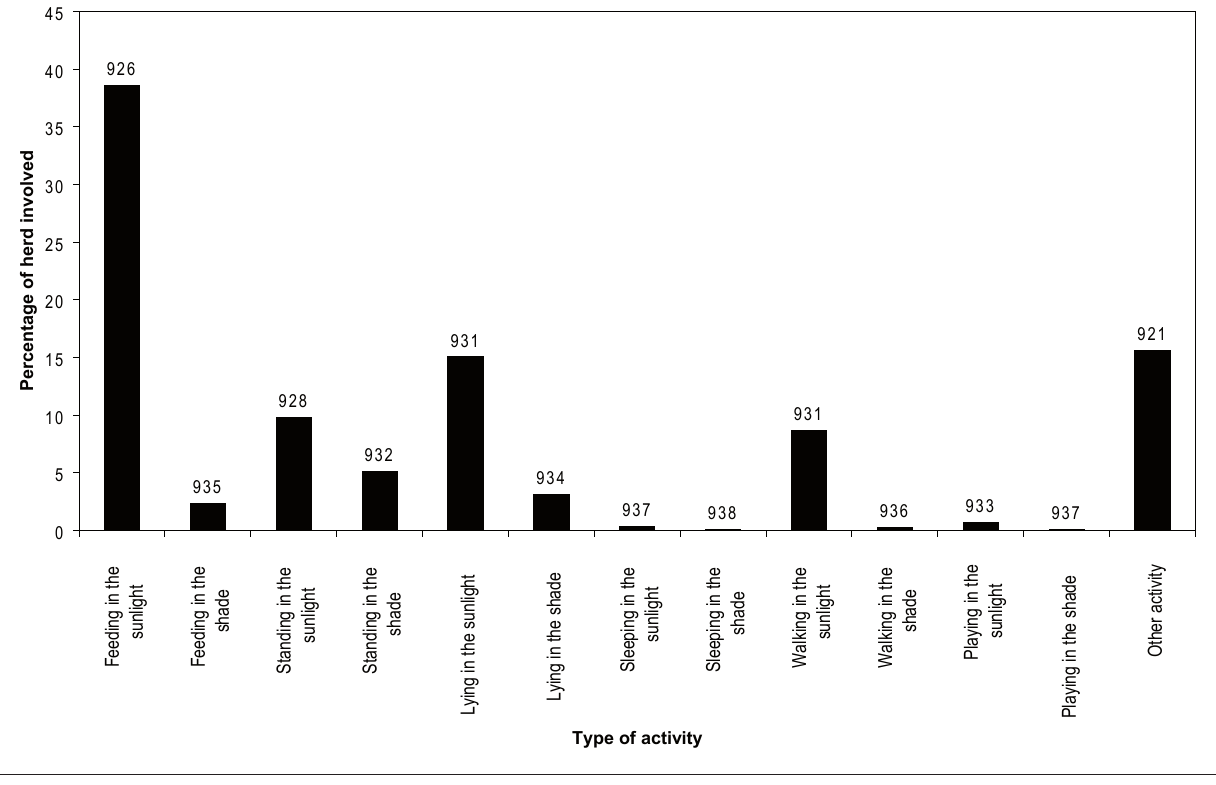
Figure 2 Mean percentage of springbok herd involved in different activities, over all time periods, during the study period from November 2002 to May 2004 in the Kalahari Gemsbok National Park. The “Other activity” category contains a collection of activities, all of which were recorded infrequently. The value on each bar in the graph indicates the sample size being used to calculate the percentage for that particular activity